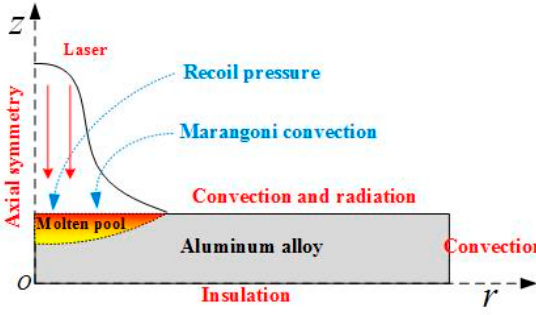
Figure 7. Schematic illustration of the physical model.